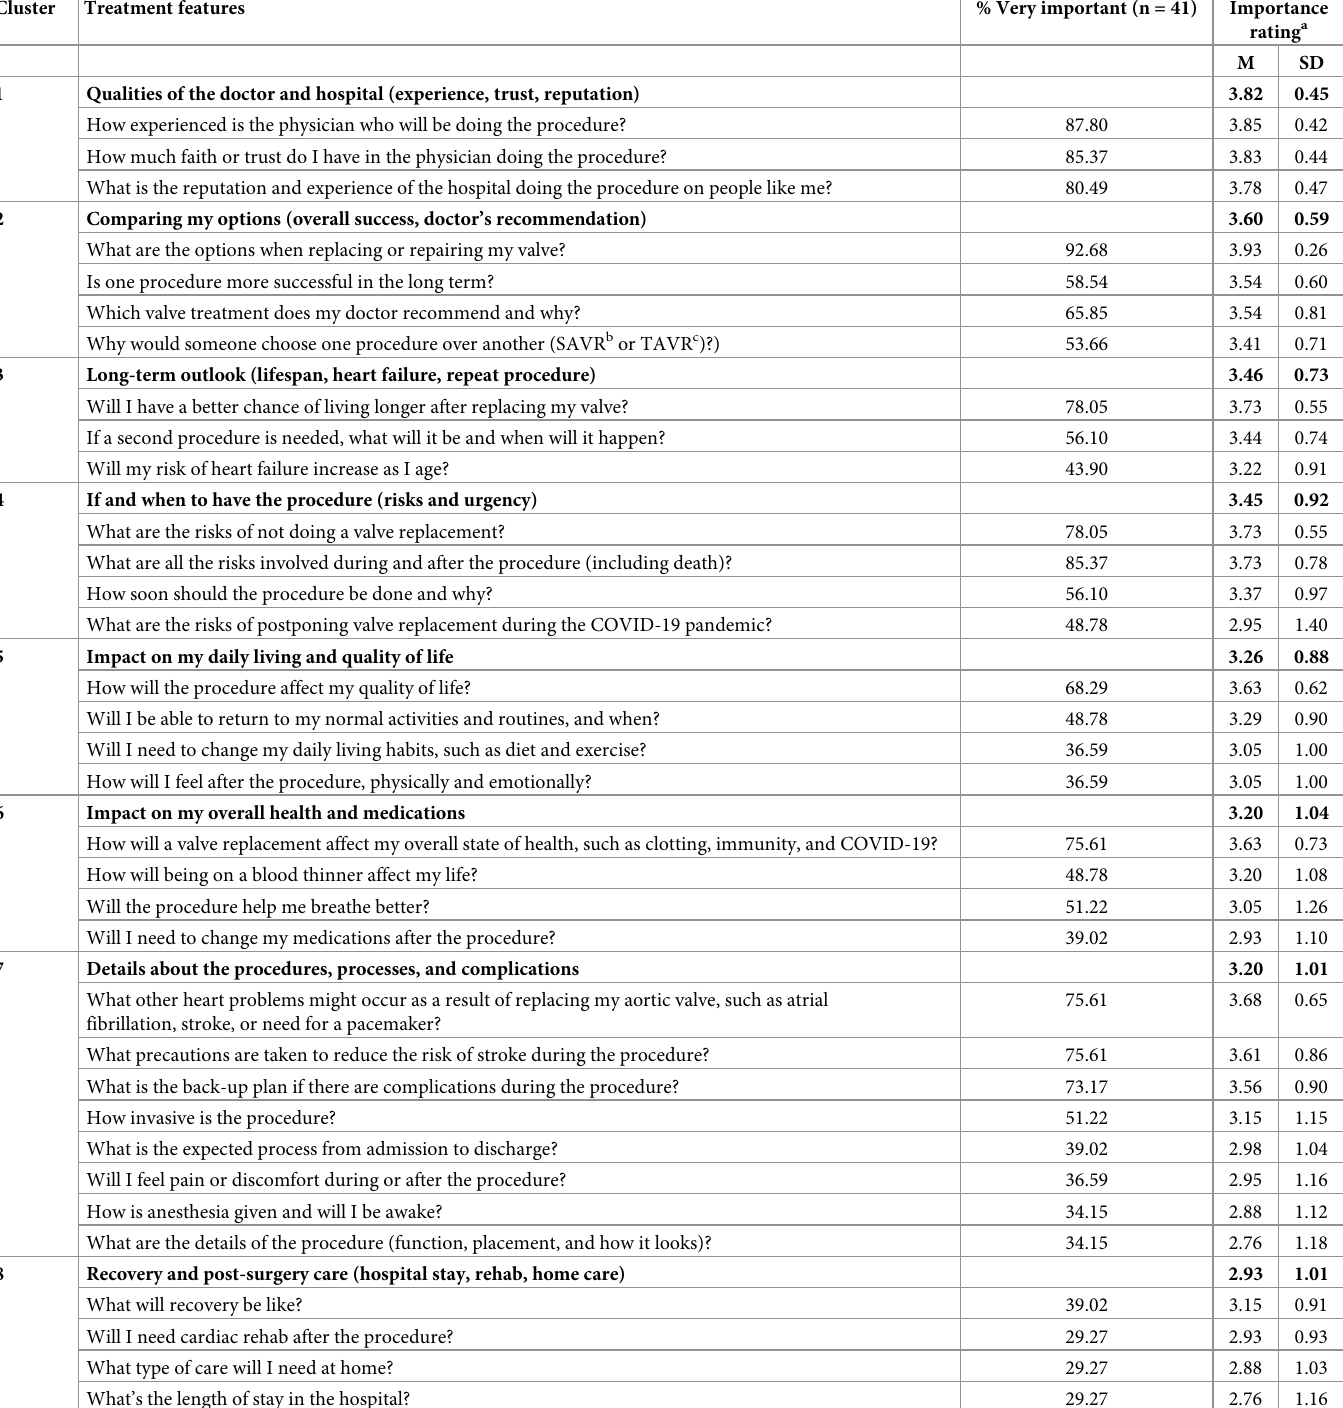
Table 3. Patient treatment features, prioritized clusters with patient ratings.